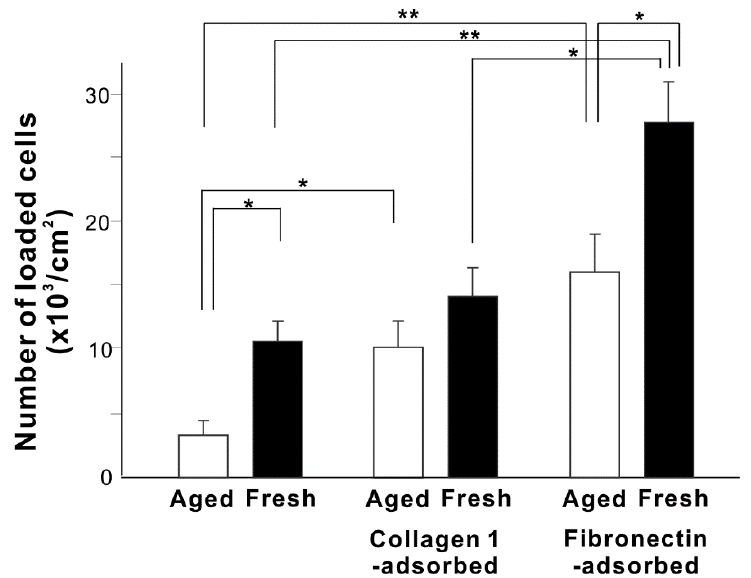
Figure 4. The ability of various titanium surfaces to load osteoblasts. The number of osteoblasts attached to titanium surfaces during a 3-h incubation was measured. Fresh and aged titanium surfaces with or without pre-adsorption of collagen 1 or fibronectin were compared. * p < 0.05, ** p < 0.01, statistically significant difference between two different surfaces.